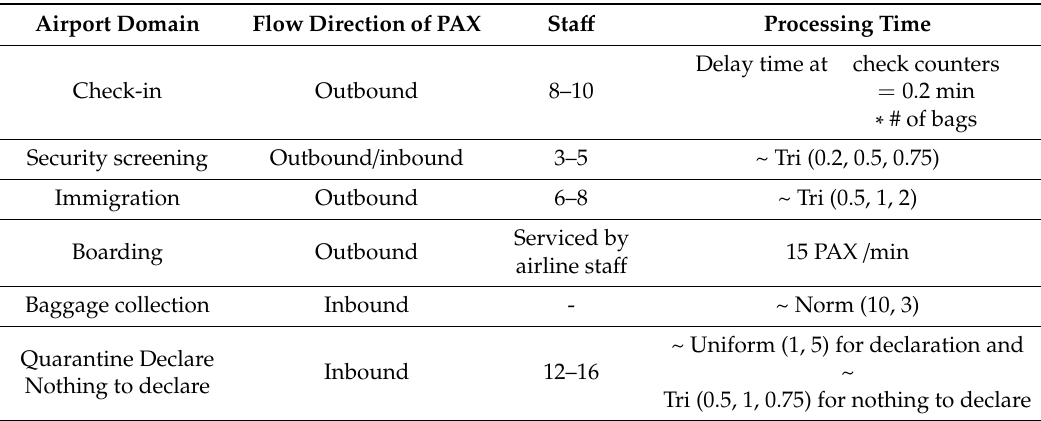
Table 1. Summary of common operational input data for the